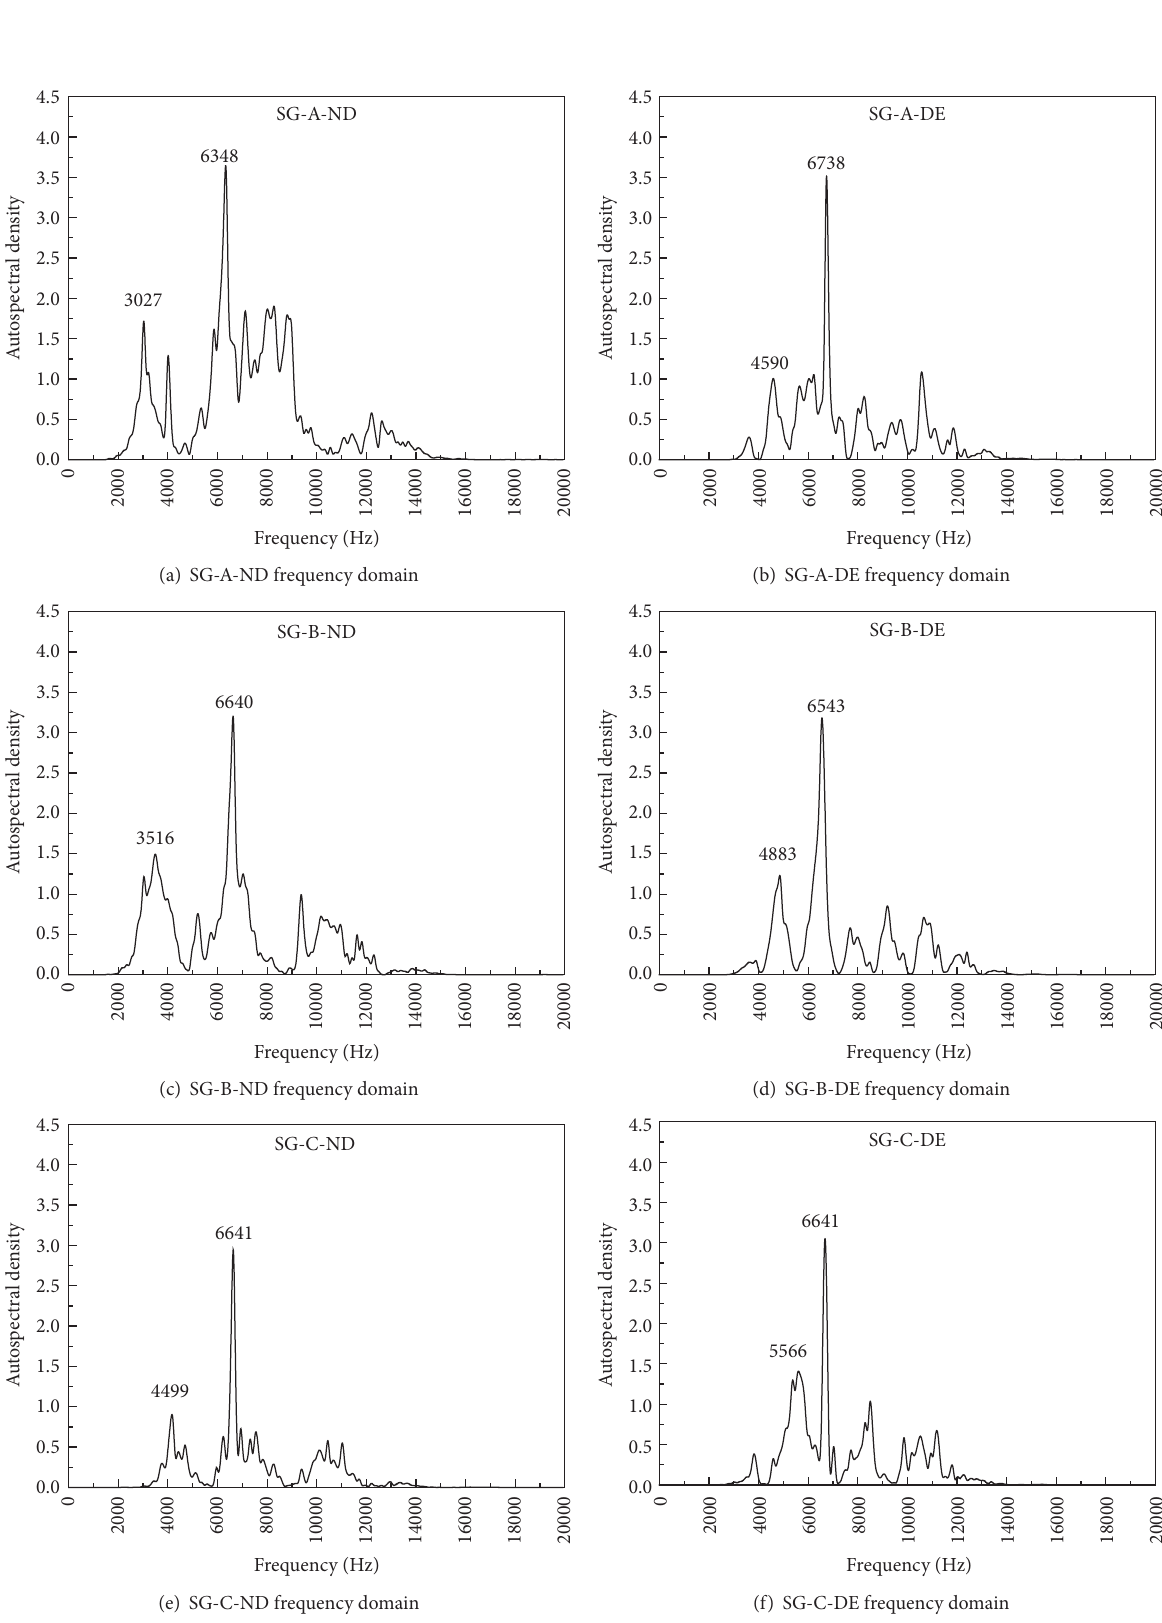
Figure 6: Frequency domain